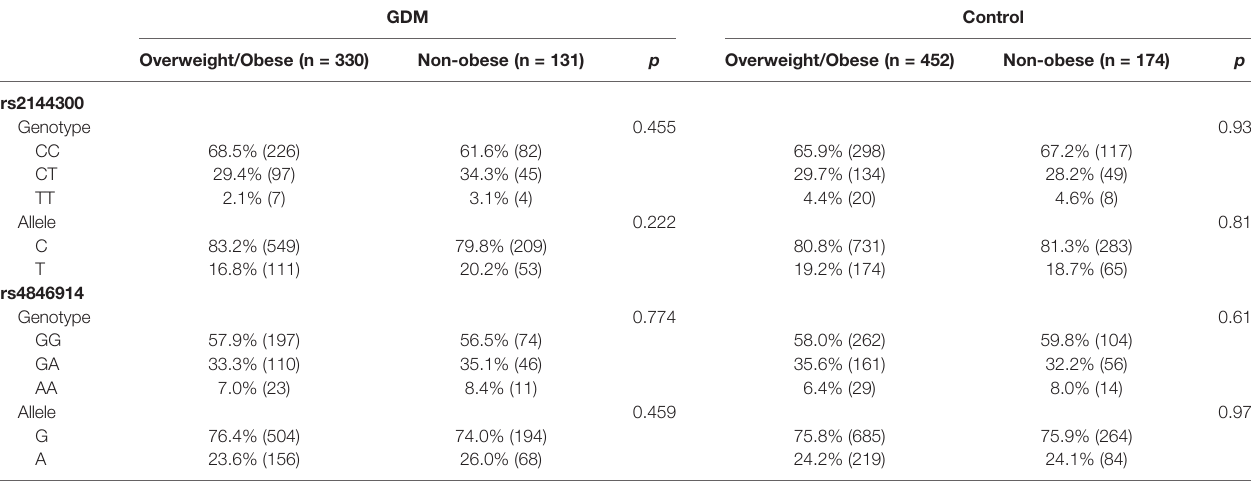
TABLE 3 | Genotype and allele frequency for the rs2144300 and rs4846914 SNPs of the GALNT2 gene in women with GDM and control subjects divided into overweight/obese and nonobese subgroups. GDM Control Overweight/Obese (n =